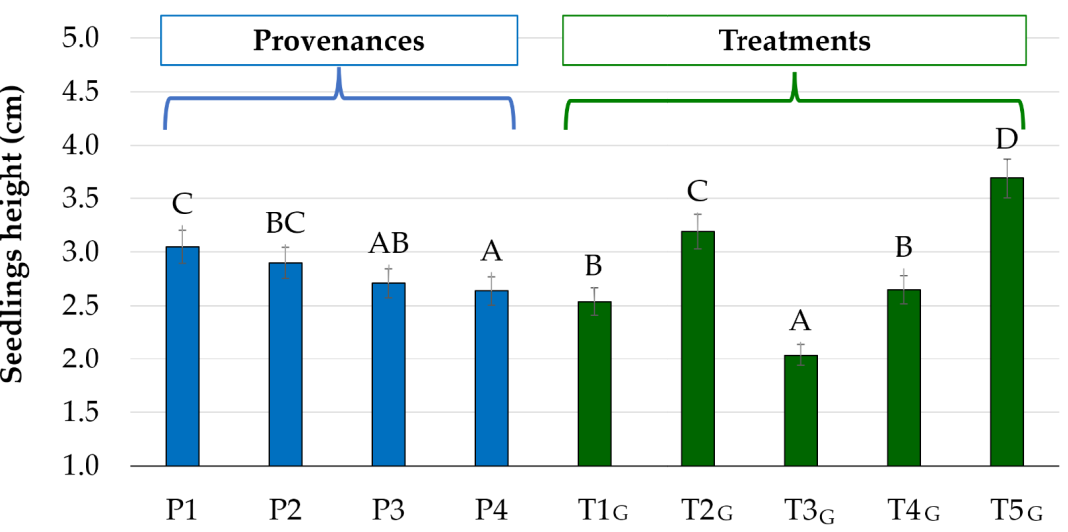
Figure 7. Seedlings’ height (cm), after G treatments, with regard to seed provenances and G treatments (mean ± SE; n = 50). The means represented with blue color reflect the influence of the provenance (P1 —Măria Mică, P2—Făina, P3—Aluniș, and P4 —Putnișoara), regardless of the treatment applied; the means represented with green color reflect the influence of the G treatment (T1 G (Control), T2 G (1 Gy-31 min), T3 G (1.5 Gy-46 min), T4 G (2 Gy-62 min), and T5 G (6 Gy-186 min)), regardless of the provenance. Different (case upper case) letters at the top of the bars indicate statistically significant differences between provenances, and respectively treatments, according to Duncan’s MRT test ( p < 0.05).